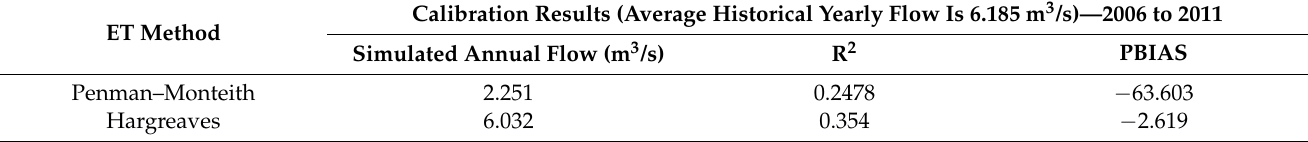
Table 6. Comparison of ET methods in calibration